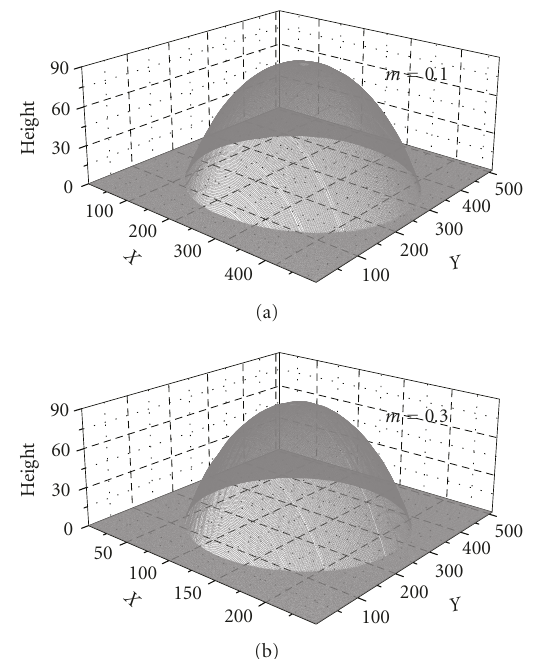
Figure 10: Reconstruction of a 3D surface by a phase-shifting technique from four fringe patterns generated with four-wavelength divergent illumination. The projection distance is z = 1 . 3m; the grating spacing is L = 0 .